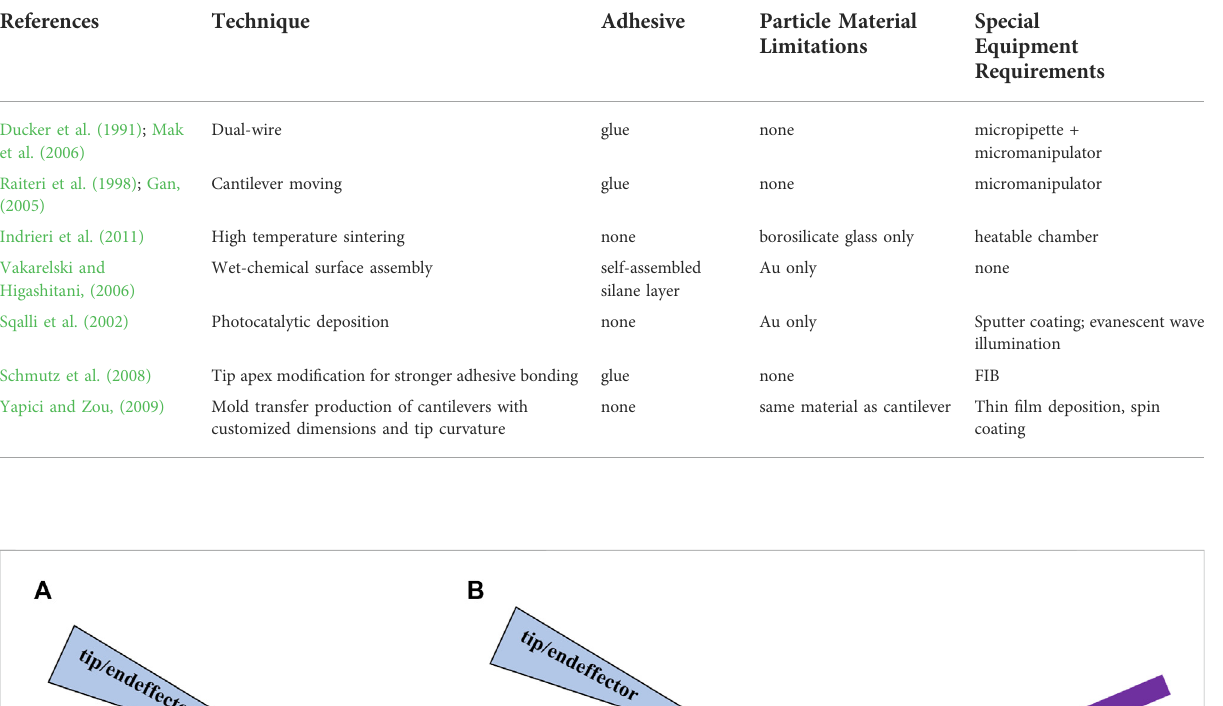
TABLE 1 Particle attachment techniques suitable for colloidal probe fabrication.